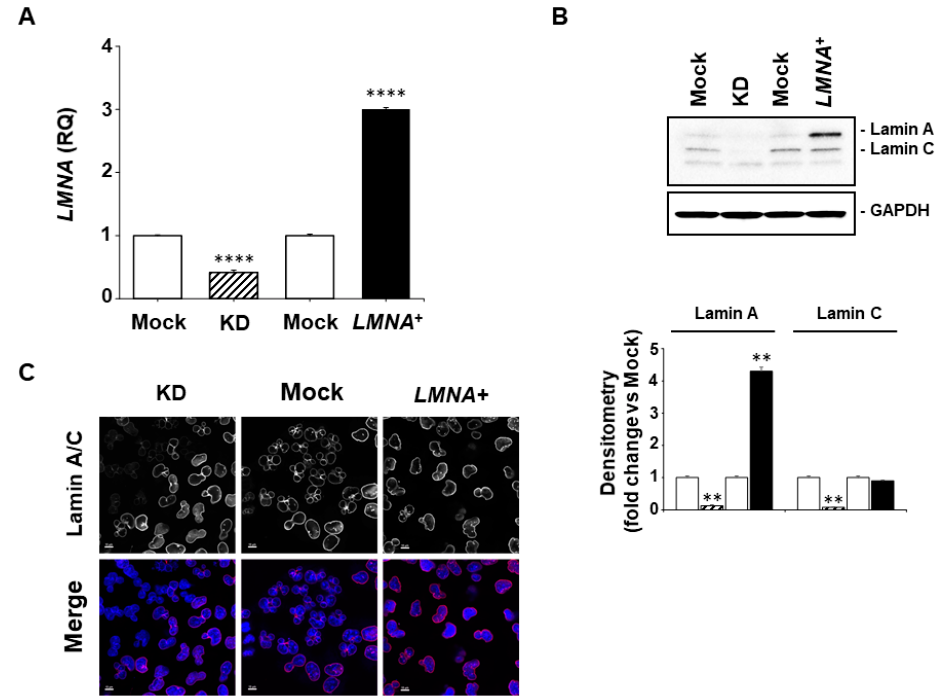
Figure 3. Modulation of LMNA gene expression in GBM T98G cells. ( A ) Relative quantification (RQ) of LMNA gene in LMNA -KD (dashed) and LMNA + overexpressed (black) T98G cells as analysed by qRT-PCR. The data are reported as the level of mRNA relative to the respective transfected vector control cells and are the means + SD (n = 3). Statistical significance: LMNA + and KD vs. mock **** p < 0.0001. ( B ) Top, representative western blot of the Lamin A/C protein in LMNA -KD (KD) and LMNA + T98G cells; bottom, blots densitometry as analyzed by ImageJ software. Values are averages + s.d. (n = 3), relative to mock cells (white) of three independent experiments with similar results. LMNA -KD (dashed), LMNA+ (black). GAPDH was used as loading control.). Statistical significance: LMNA + and KD vs mock ** p < 0.01. ( C ) Representative confocal images of mock, LMNA -KD (KD) and LMNA + cells. Red, Lamin A/C immunostaining; blue, DAPI. Scale bar: 10 microns.